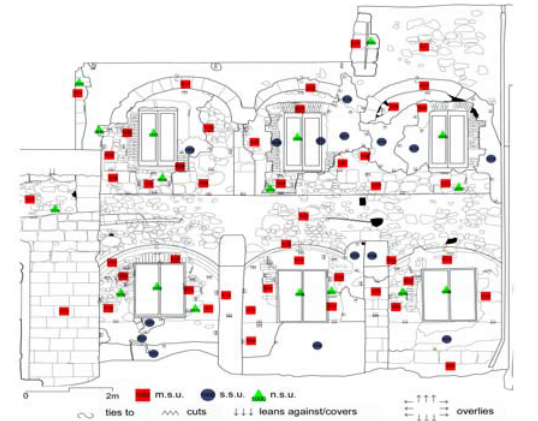
Figure 10: Detail of the north facade, stratigraphic analysis of the